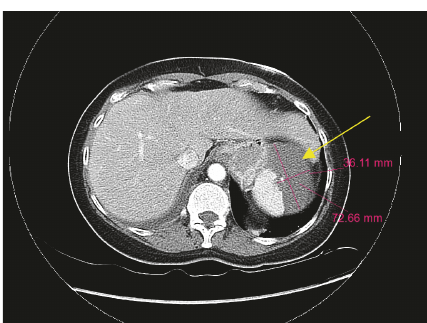
Figure 1: Computed Tomography (CT) of the abdomen done at admission with intravenous and oral contrast: the yellow arrow shows a high-density fluid filled large defect in the superior aspect of the spleen consistent with splenic infarct.